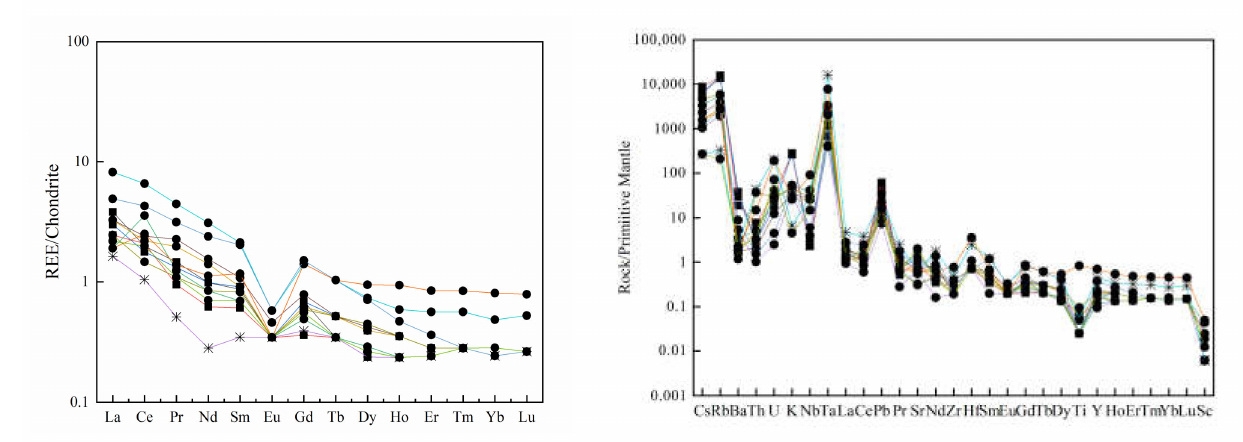
Figure 8. ( Left ) Chondrite normalized REE pattern; ( Right ) Primitive mantle normalized trace elements spidergram; Symbols are the same as Figure